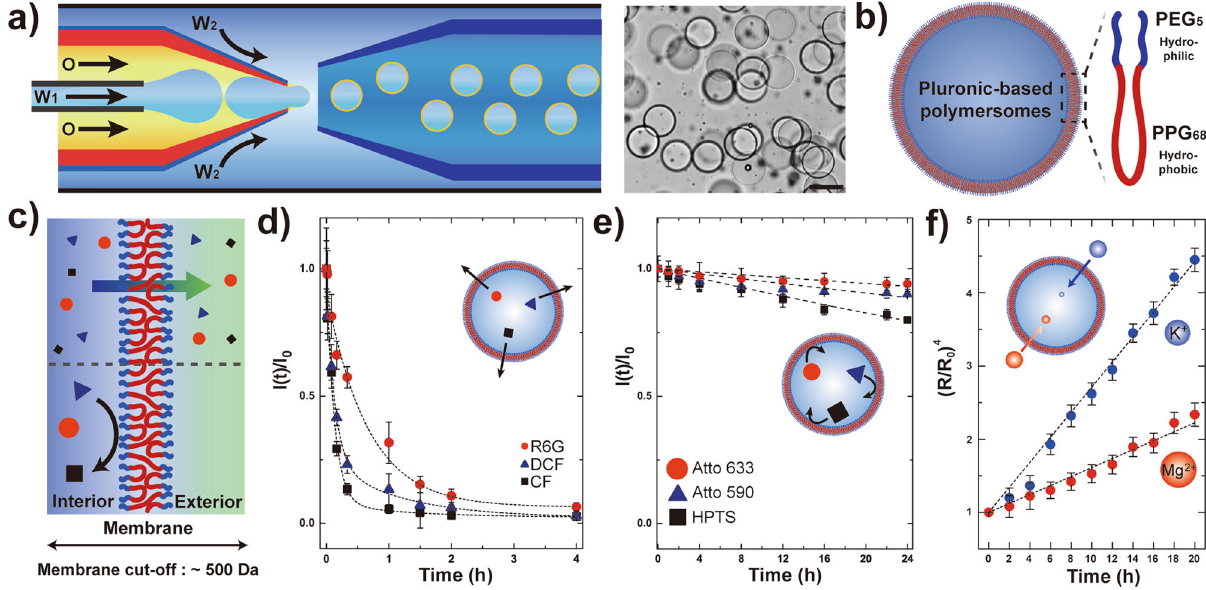
Fig. 1 | Micro fl uidic fabrication of semi-permeable polymersomes. a Schematic illustration and optical micrograph showing the production of Pluronic-based polymersomes via glass capillary-based micro fl uidic device using water-in-oil-in- water (W 1 /O/W 2 ) double emulsion droplets as templates. Scale bar represents 100 µ m. b Schematic illustrations of the produced polymersomes consisting of Pluronic L121. PEG: poly(ethylene glycol), PPG: poly(propylene glycol). c Schematics illustrating the experiment used to determine the membrane per- meabilitytowards fl uorescent dye molecules with different molecular weight and charge. Fluorescent dyemolecules with molecular weight <500Da readily diffuse through the membrane (top) while the larger ones do not (bottom). d Plot showing the normalized fl uorescence intensity change within the polymersomes overtimeforthreerepresentative fl uorescentdyemoleculessmallerthantheMW cut-off of the membrane. Small cationic dye (red circle) refers to Rhodamine 6G